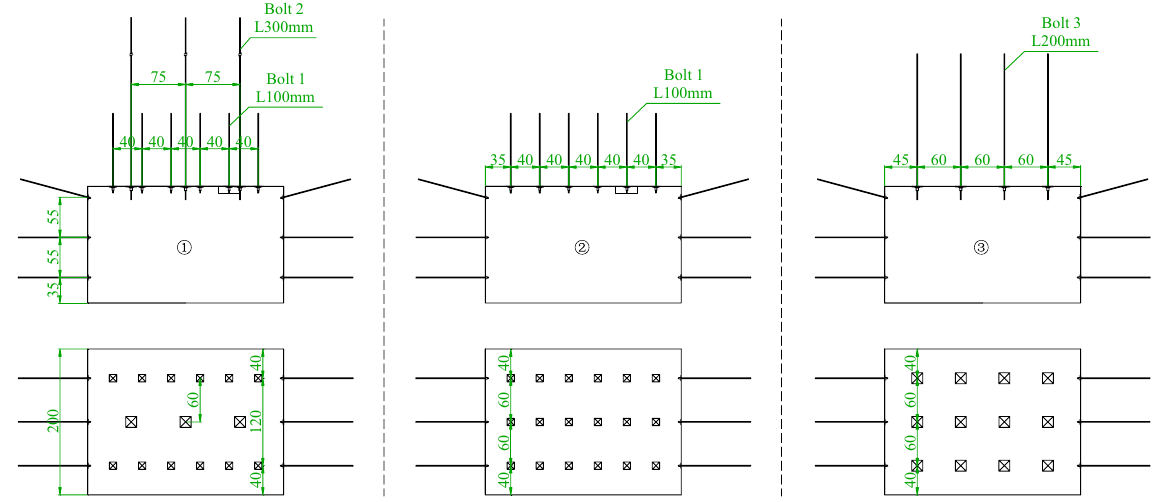
Figure 10. Design diagram of test roadway support.